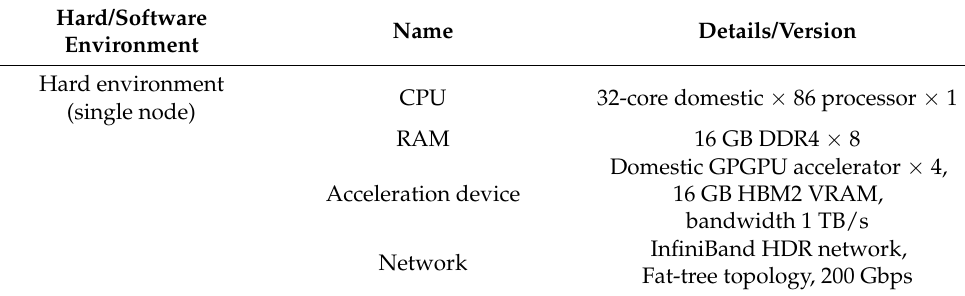
Table 1. SunRising-1 experimental